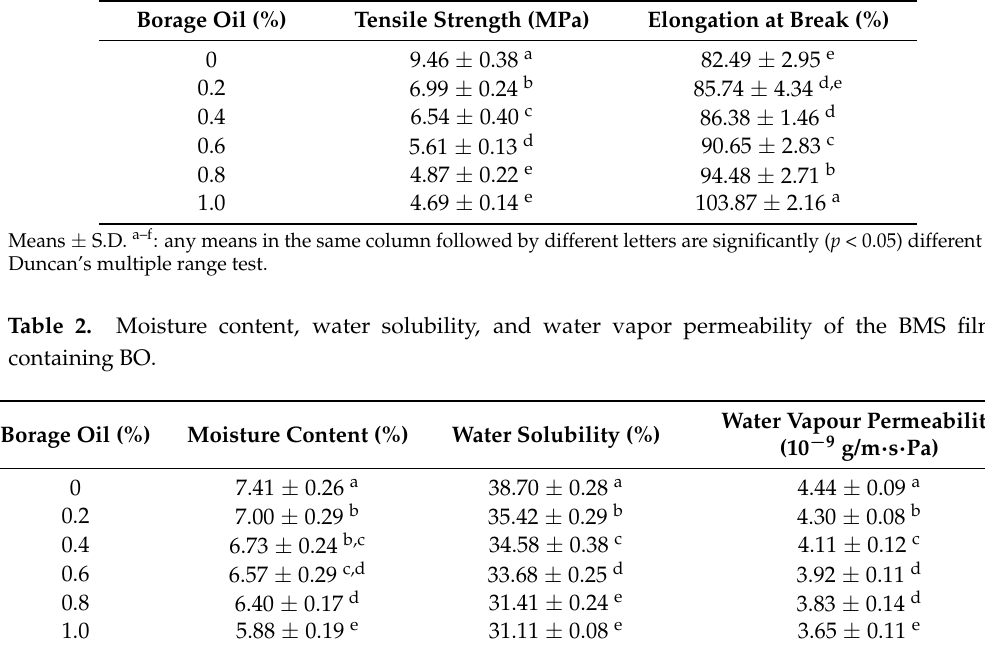
Table 1. Physical properties of the BMS films containing BO.